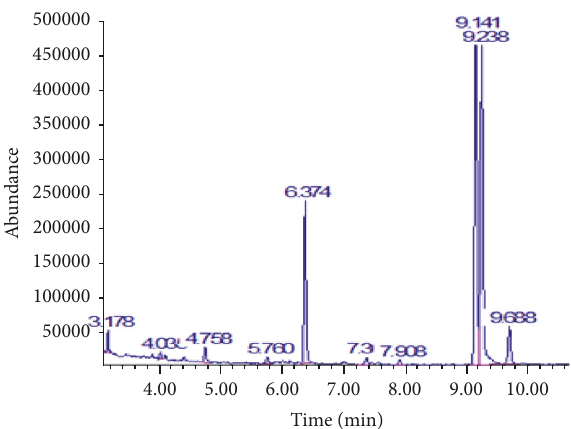
Figure 7: Chromatograms of biodiesel obtained by immobilized enzyme transesterification of frying oil.